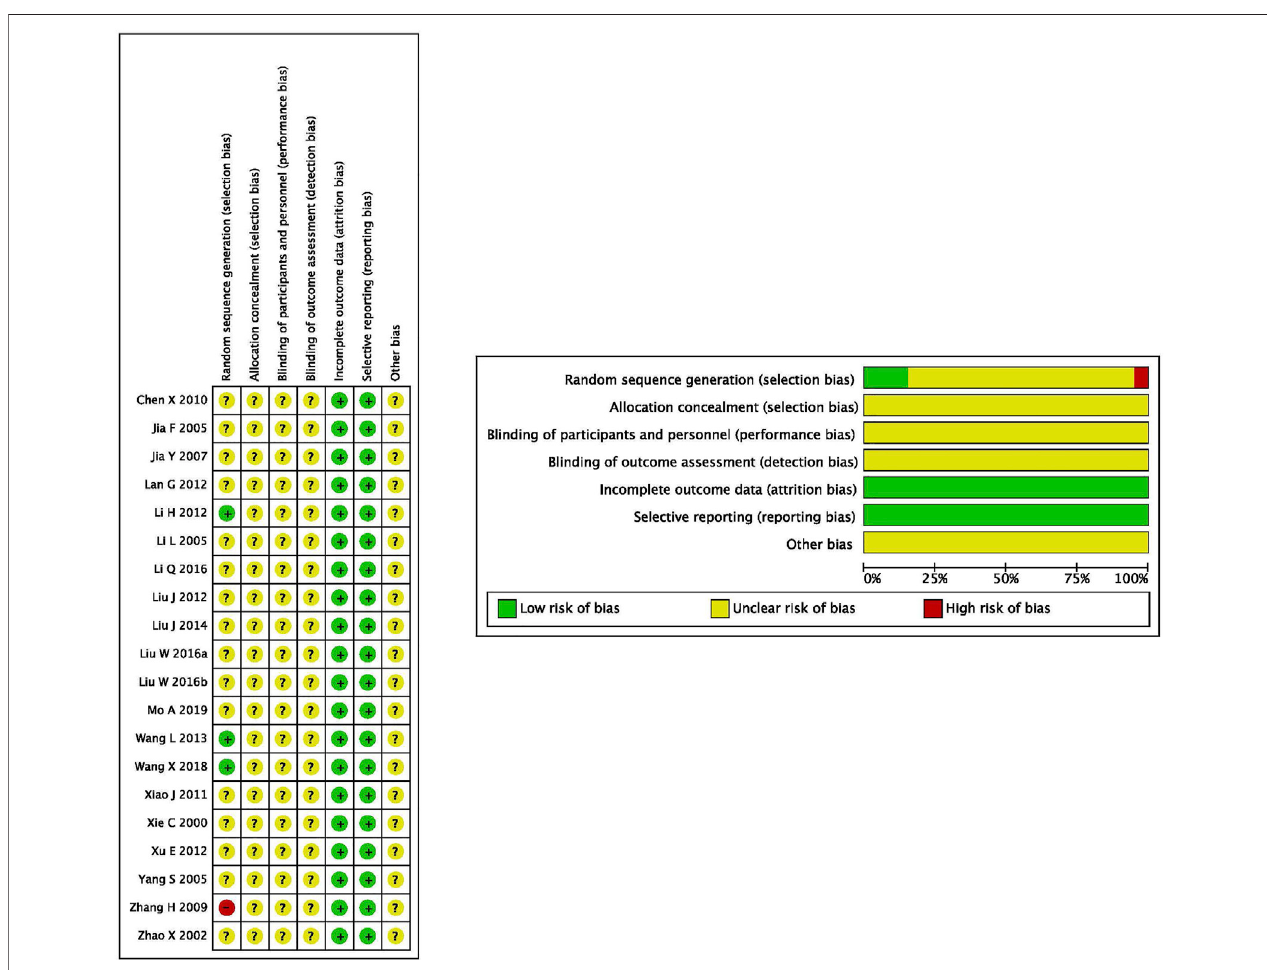
FIGURE 2 | Quality evaluation of included studies: according to the criteria made by the Cochrane Handbook (Version 5.0.1), no heterogeneity existed in eligible RCTs; Overall, these studies had moderate to higher quality.